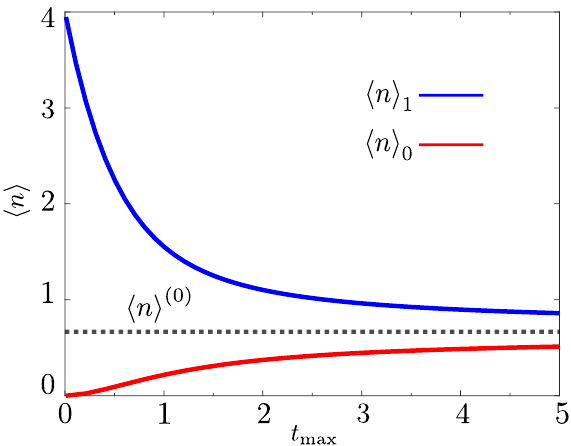
. The latter is measured in units of ω − 1 . max 〉 = | 1 〉 , in the case | ψ r 1 for the choice 0